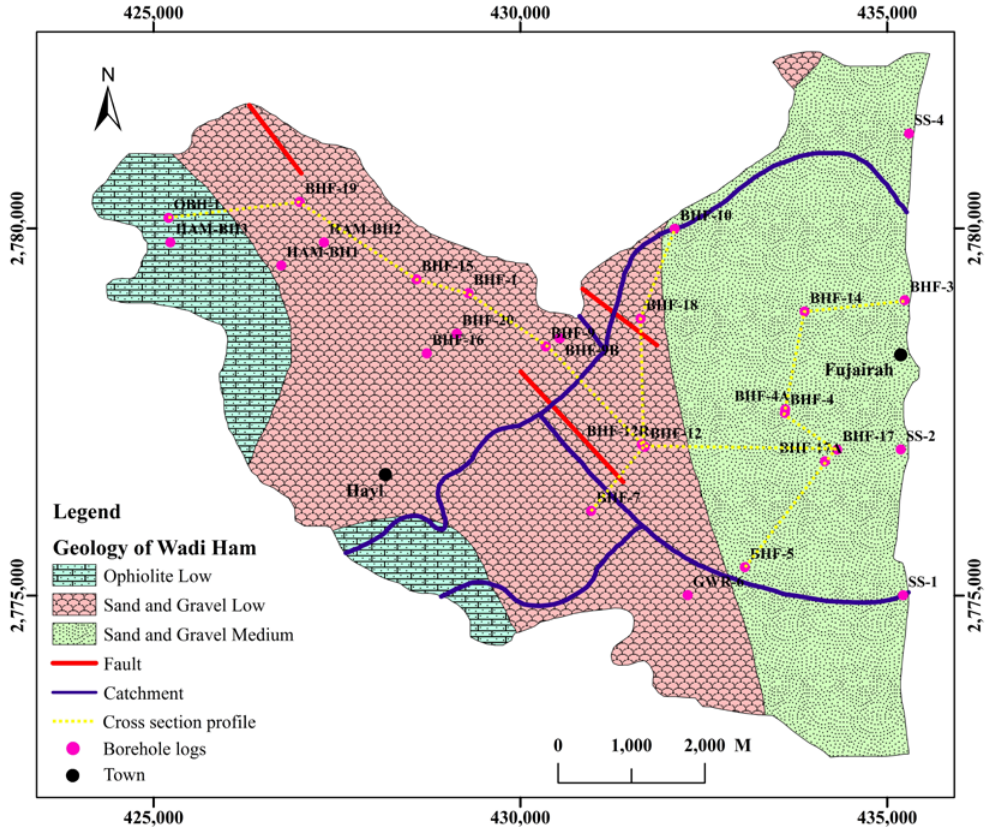
Figure 3. Geological map of Wadi Ham [26].